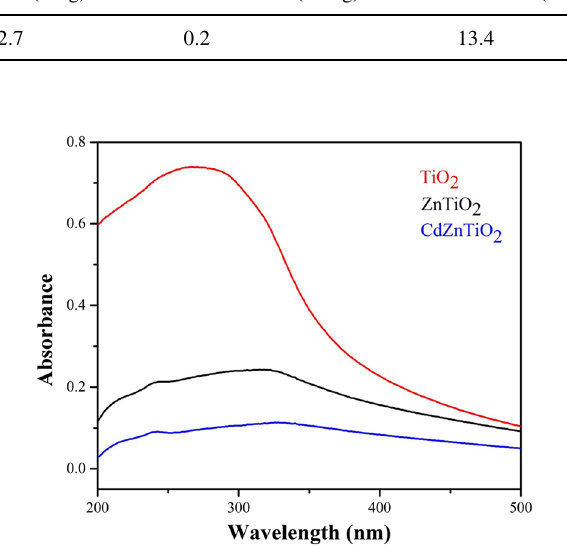
Fig. 5 UV–visible absorption spectra of TiO